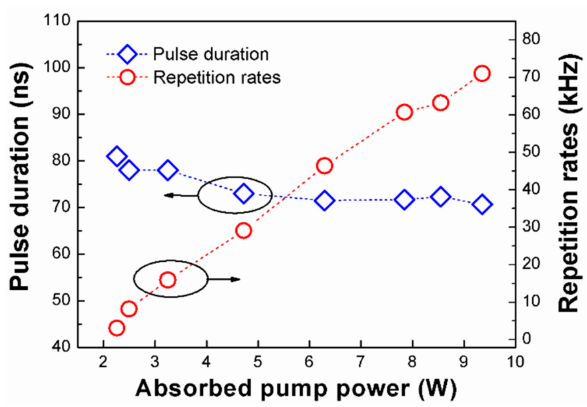
Figure 3. Measured pulse duration and repetition rate as function of the absorbed pump